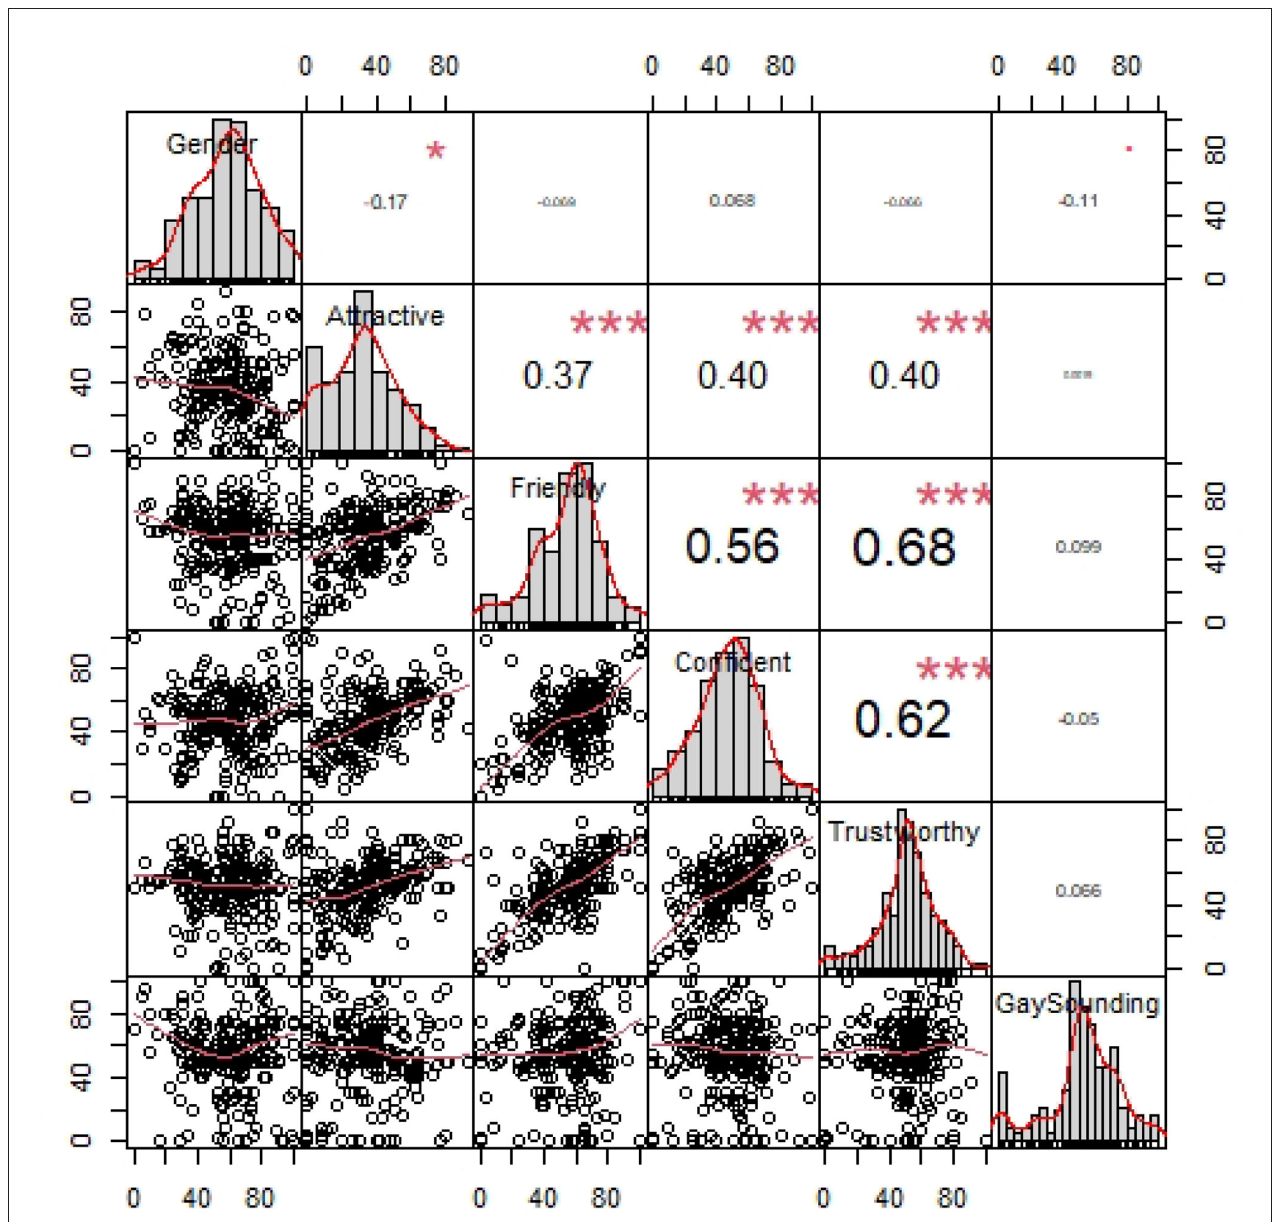
FIGURE 1 | Correlations between the ratings across different vocal attributes. Each point corresponds to the ratings of a participant. ∗∗∗ p < 0.001; ∗ p <